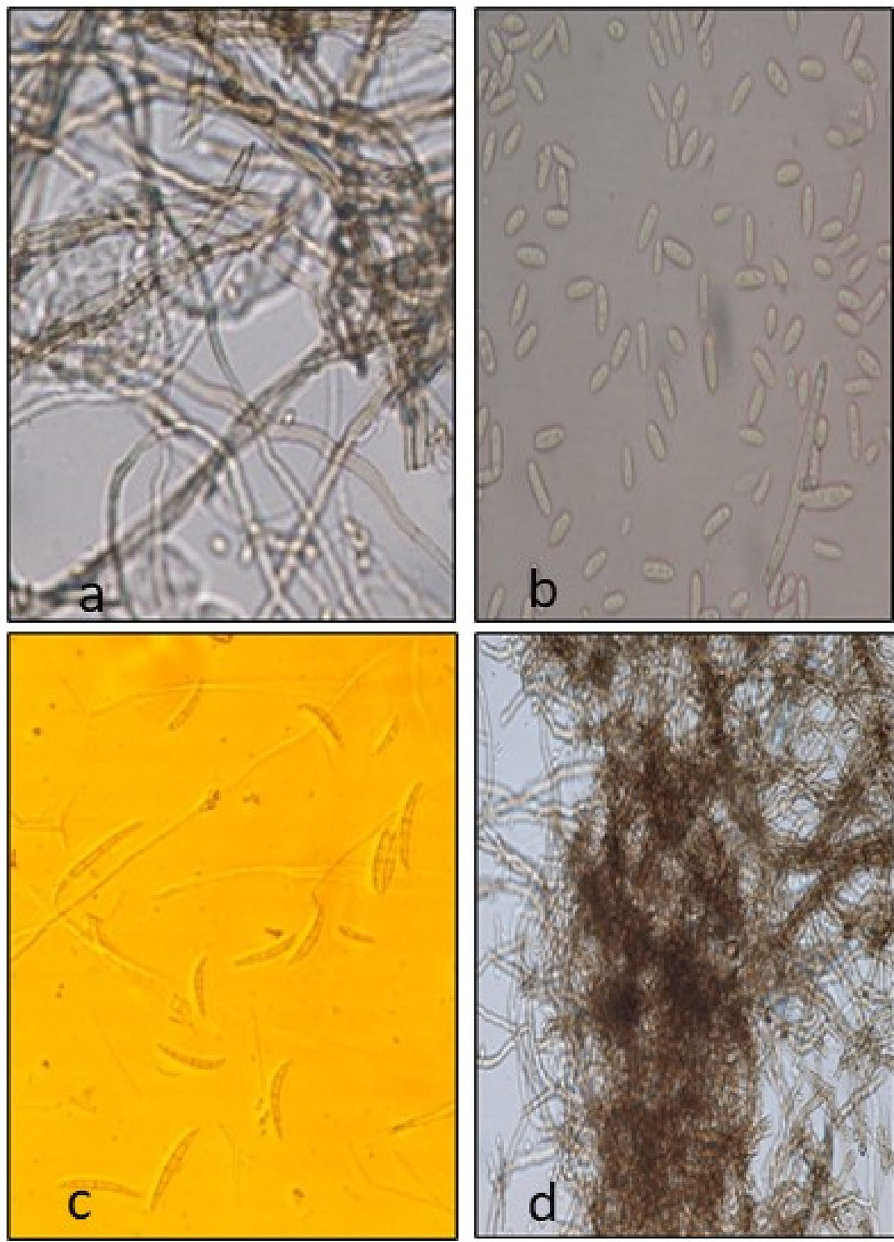
Figure 3. Morphological characteristics of the pathogen. ( a ) Mycelium, ( b ) micro conidia, ( c ) macro conidia, ( d ) chlamydospores.